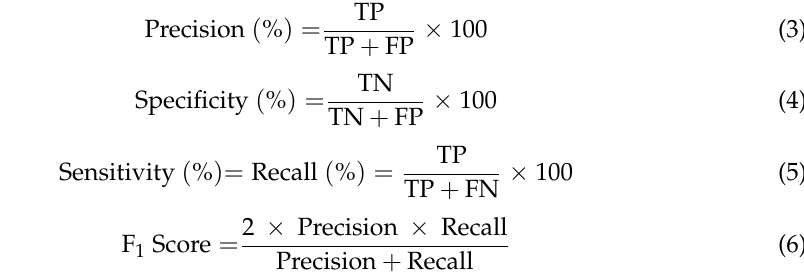
Confusion matrices; Figure S3: ROC curves; Figure S4: Confusion matrices; Figure S5: ROC curves; Figure S6: Mean decrease in accuracy and Gini index by RF; Figure S7: LSTM unit; Figure S8: Confusion matrices; Figure S9: ROC curves; Figure S10: Confusion matrices; Figure S11: ROC curves; Figure S12: Mean decrease in accuracy and Gini index by RF; Figure S13: Model architecture; Figure S14: Model architecture; Figure S15: Basic unit; Table S1: